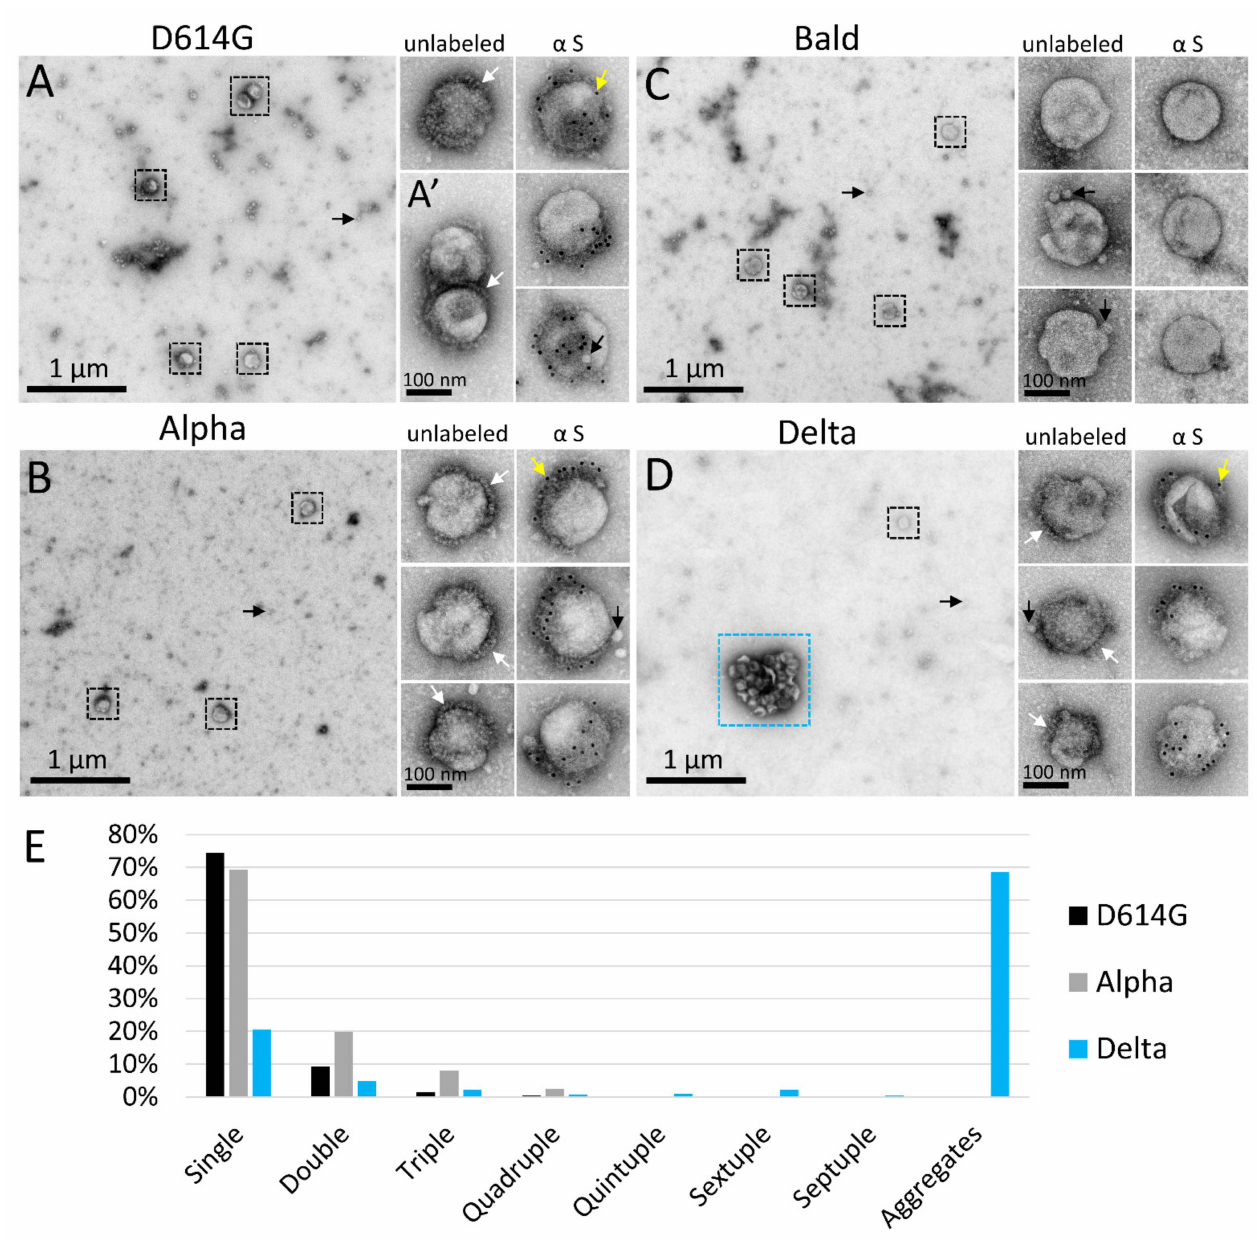
Figure 1. Negative stain TEM detects unique aggregation of PVs bearing the Delta spike. ( A – D ) Low magnification negative stain TEM overviews of PVs bearing SARS-CoV-2 spike variants ( A ) D614G, ( B ) Alpha, ( C ) Bald, or ( D ) Delta. Black boxes surround individual PVs; blue box indicates an aggregate of Delta PVs. To the right are enlarged views of individual unlabeled PVs and PVs immunogold labeled for spike protein. ( A’ ) Example of a doublet of D614G PVs. White arrowheads show areas on PVs where a fringe of spike proteins is clearly visible. Yellow arrowheads indicate 10 nm immunogold particles labeling the spike S1 subunit, which appear as black dots. Small black arrows indicate lipoprotein-like particles. ( E ) Frequency of singles, multiples, and aggregates of eight or more PVs per